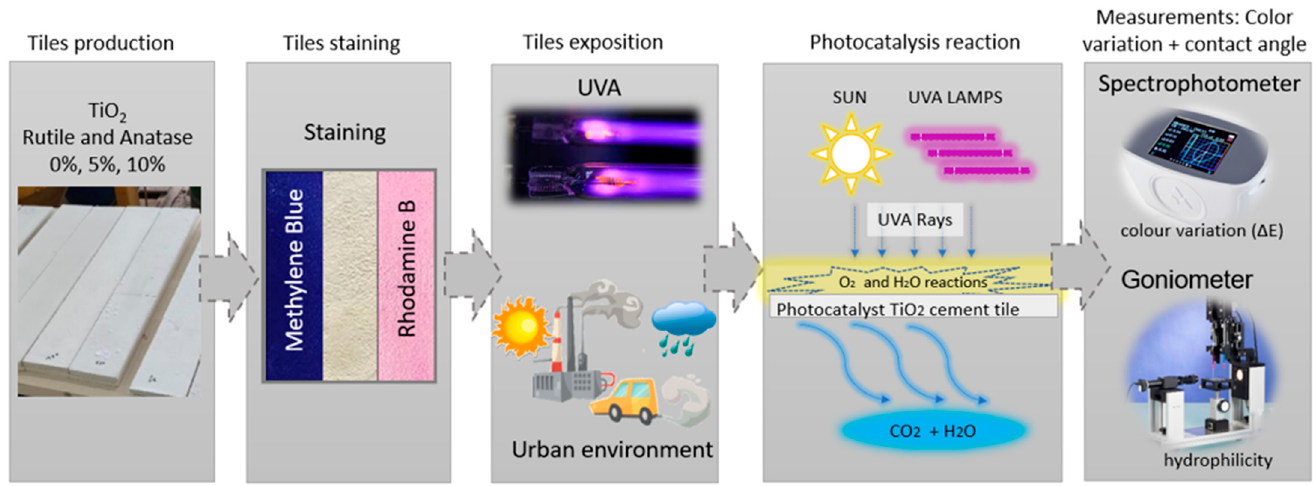
Figure 1. Schematic representation of the experimental